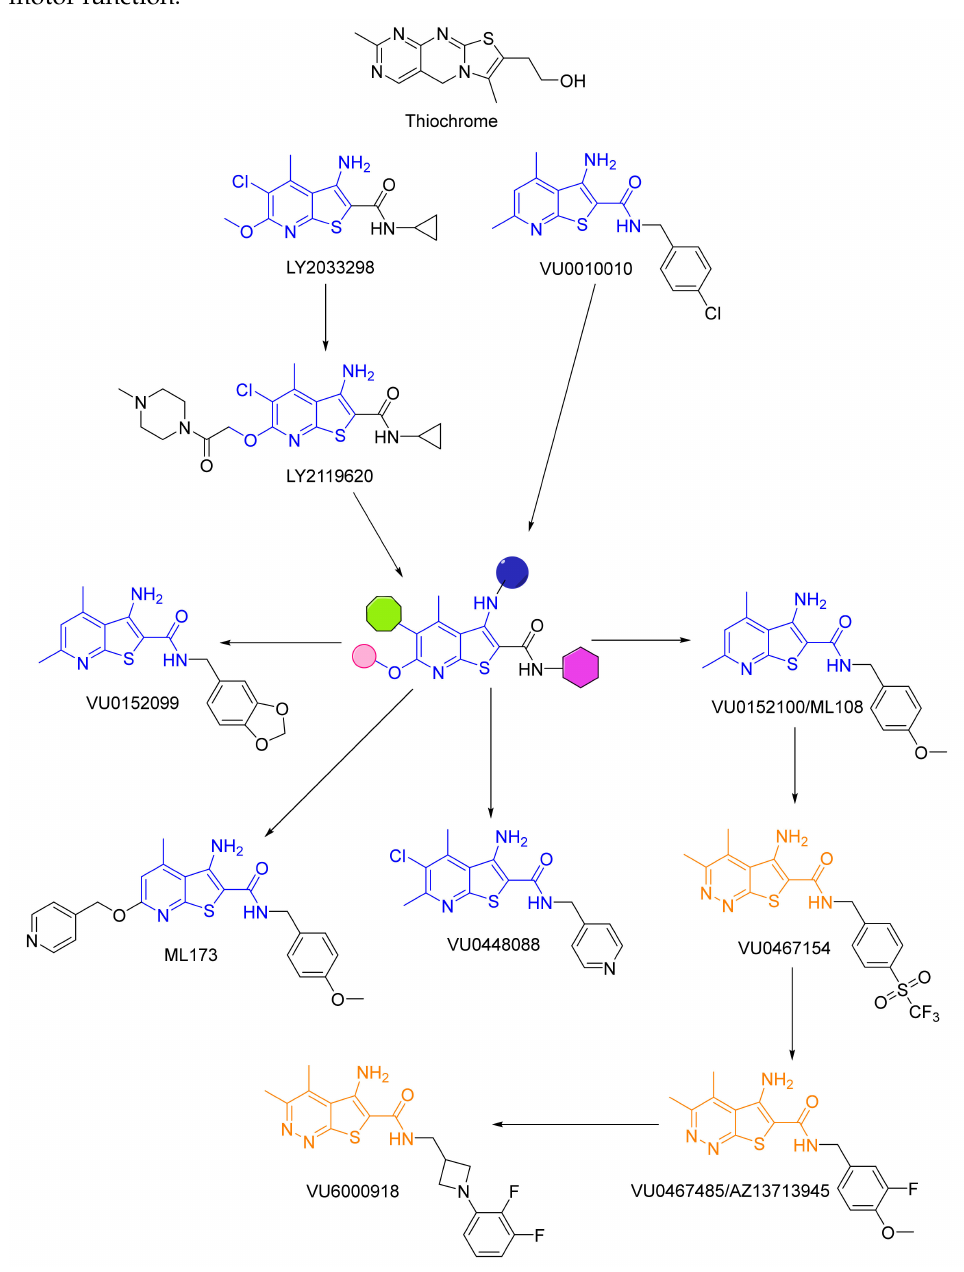
Figure 6. Optimization campaign to arrive at examples of highly selective dual M 1 /M 4 (or M4)